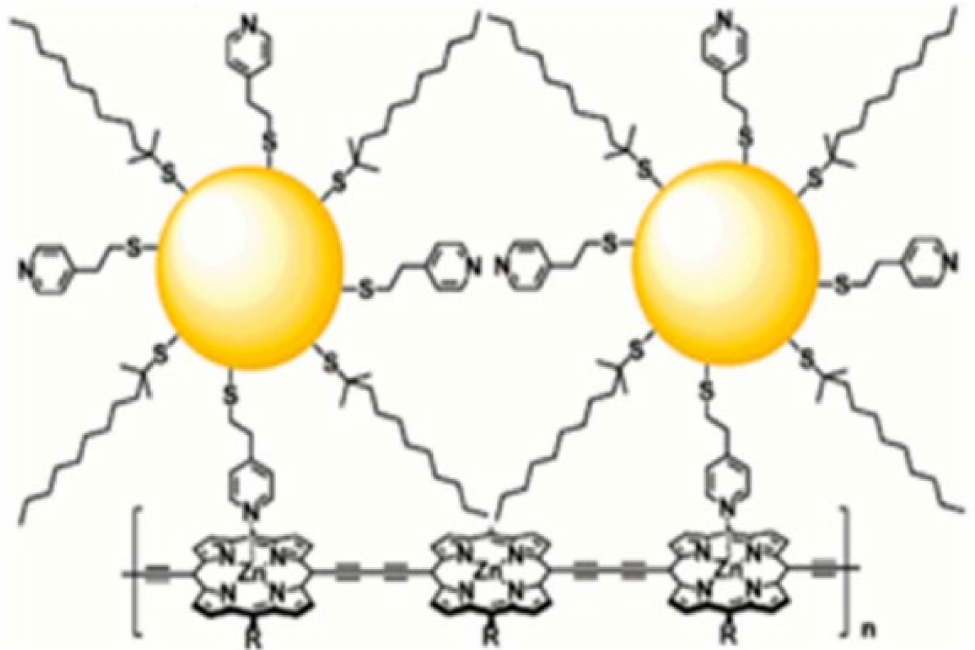
Figure 19. 1D- Au NP chemically connected to porphyrine conjugated, reproduced by reference permission, ACS, 2007